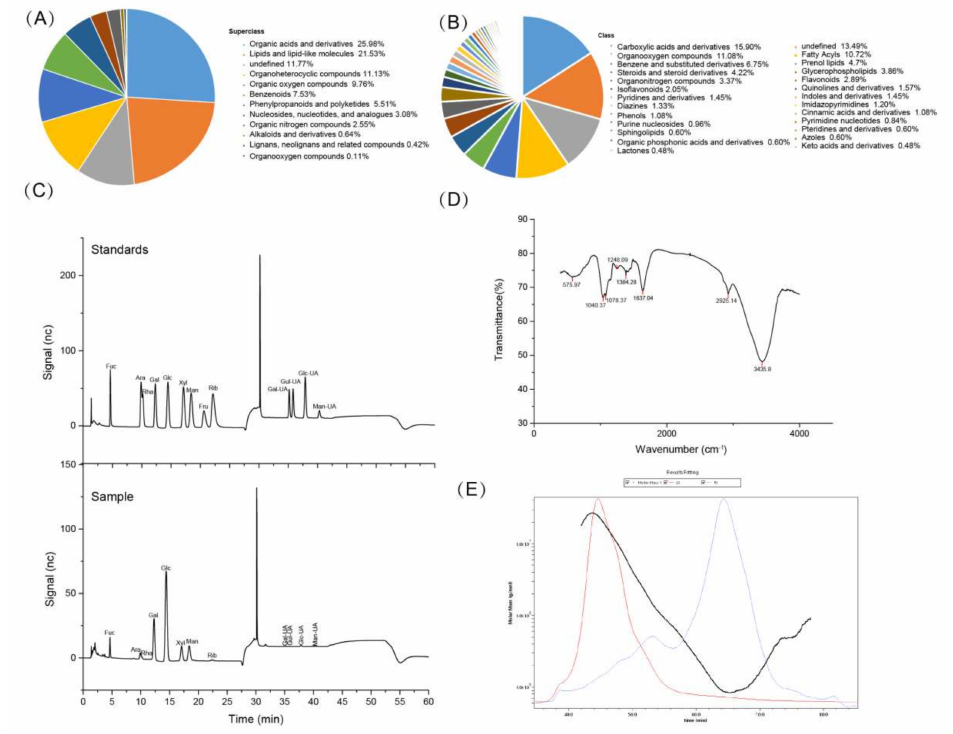
Figure 1. The composition of FV mycorrhizae and characteristics of polysaccharides from FV mycor- rhizae were determined. ( A ) Superclass; ( B ) Class; ( C ) The ion chromatography of monosaccharide mixture standards and polysaccharides from FV mycorrhizae; ( D ) The FT-IR spectrum; ( E ) Chro- matograms of the molar mass